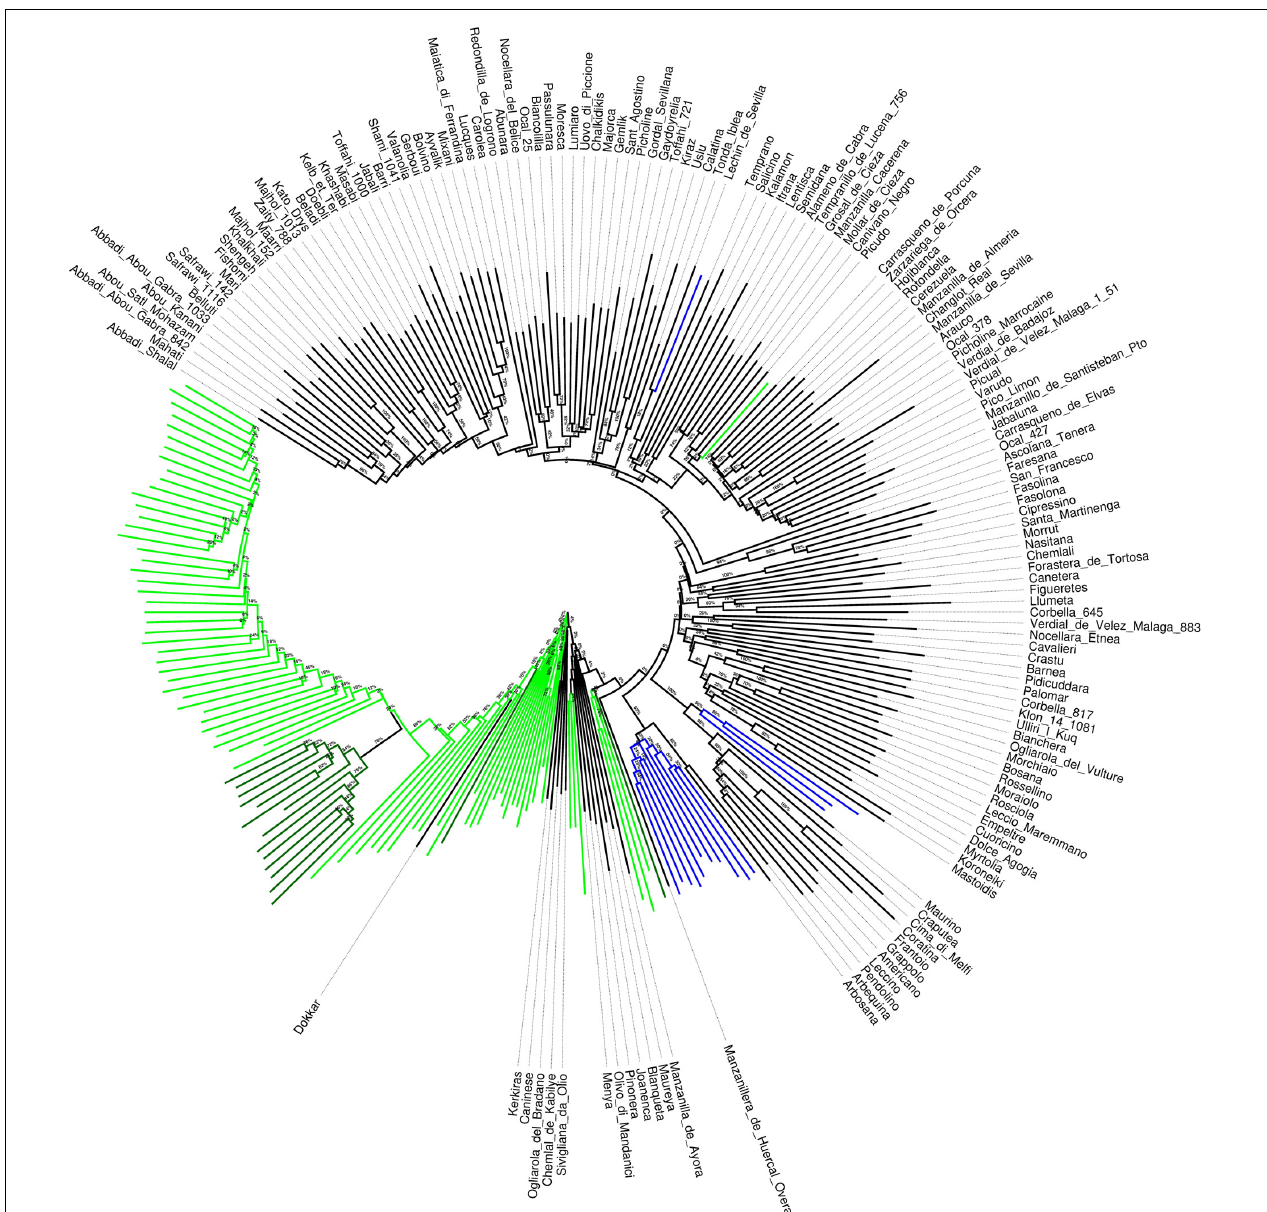
FIGURE 2 | Neighbor joining dendrogram of wild olives, cultivated varieties and the genotypes from the cross ‘Picual’ x ‘Arbequina’ cultivars. Green branches correspond to wild olives, light green to the wild olives from Canary Islands, Blue branches refer to the crossbred progenies. Bootstrap values are reported as percentage at each branch